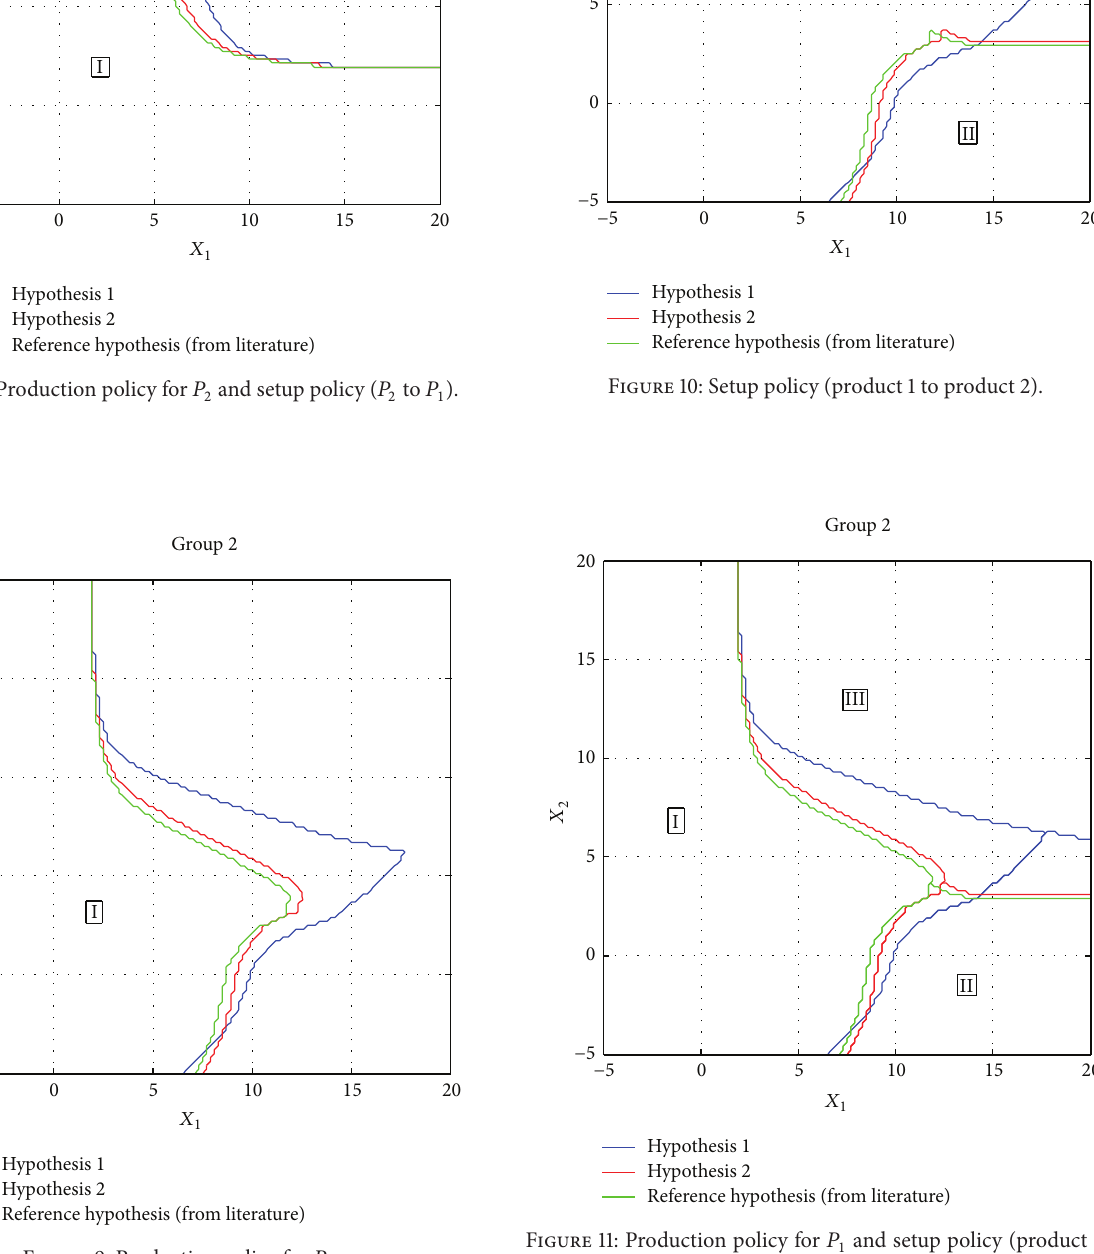
Figure 9: Production policy for 𝑃 1 .